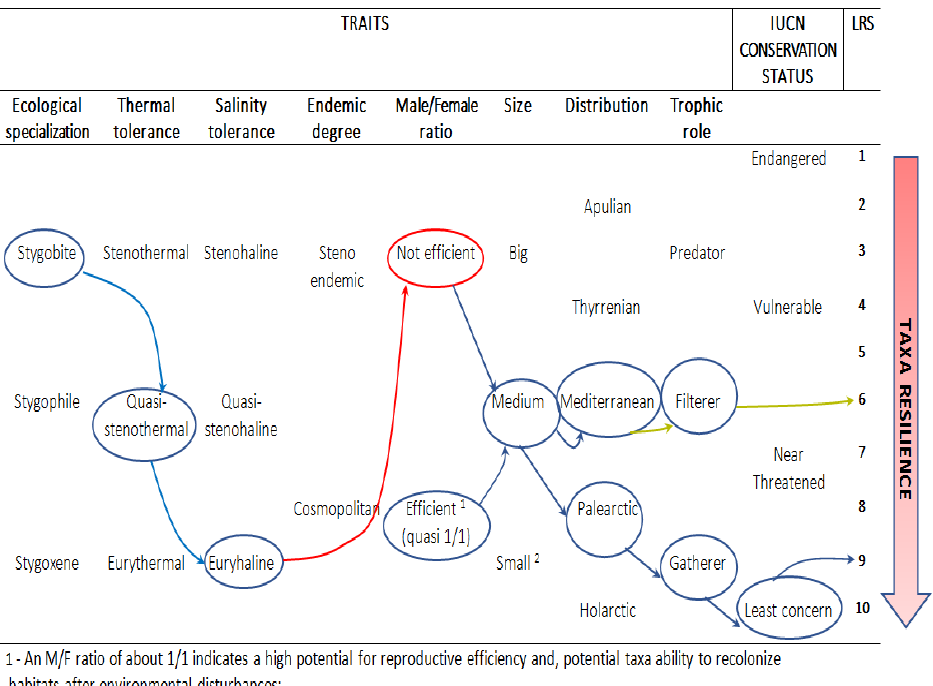
Figure 2. Decisional flow visualization of local resilience score (LRS) attributions to the sampled stygofauna at Murgia and Salento groundwater.